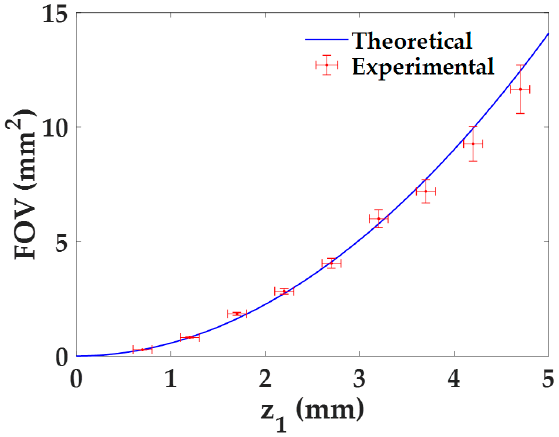
Figure 4. FOV characterization as a function of the distance z 1 for the proposed lensless holographic microscope.